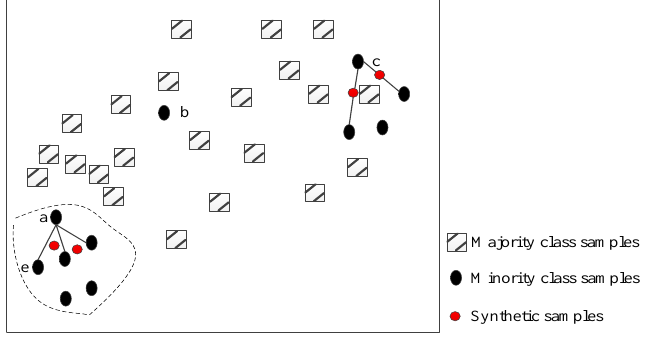
Figure 3. Diagram of the SISMOTE